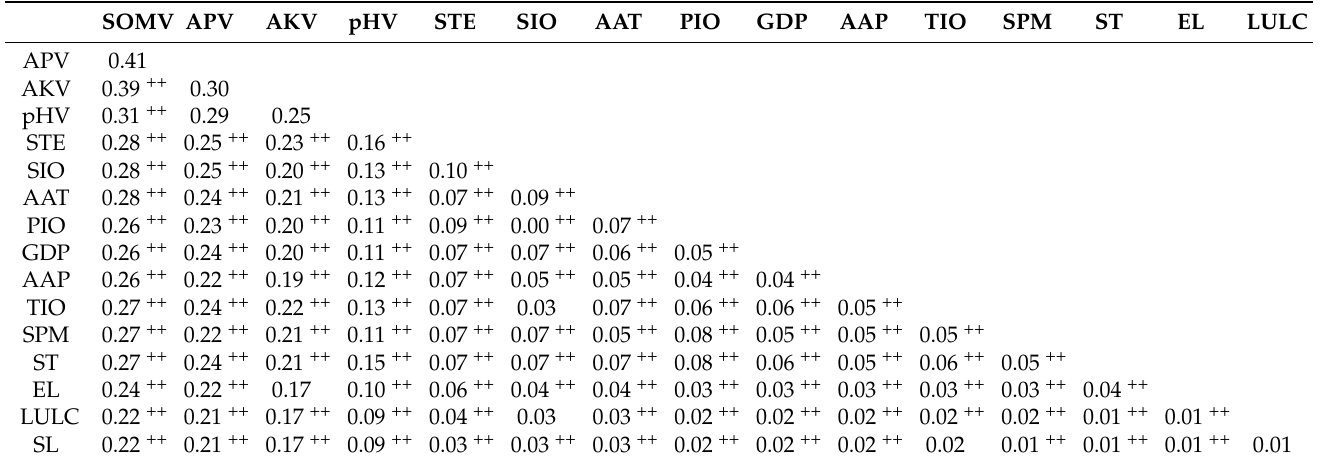
Table 4. The interaction effects between factors on cultivated land quality